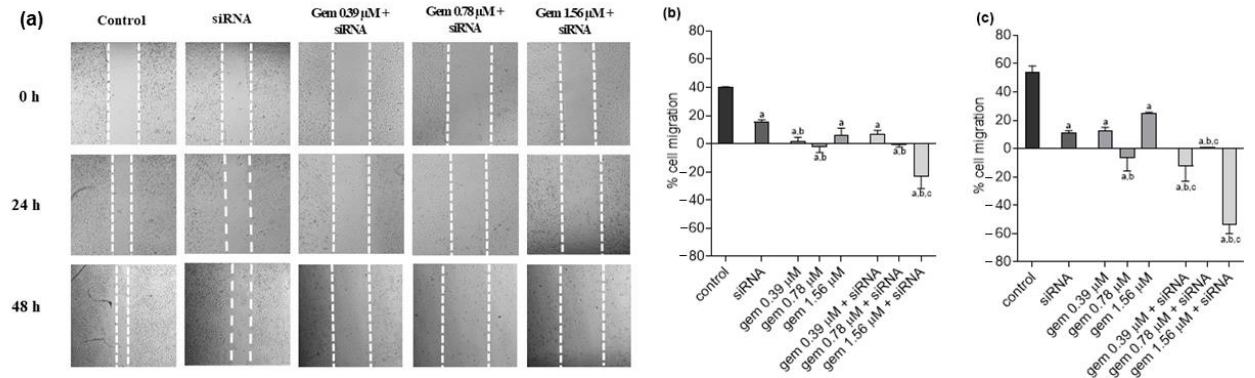
Figure 7. Photographs ( a ) and quantification ( b , c ) of cell migration in J82 cells after treatment with gemcitabine, siRNA JHDM1D-AS1 , or gemcitabine combined with siRNA JHDM1D-AS1 . Control: untreated cells; gem: gemcitabine. a: p < 0.05 compared to control; b: p < 0.05 compared to siRNA; c: p < 0.05 compared to respective gemcitabine concentration alone.